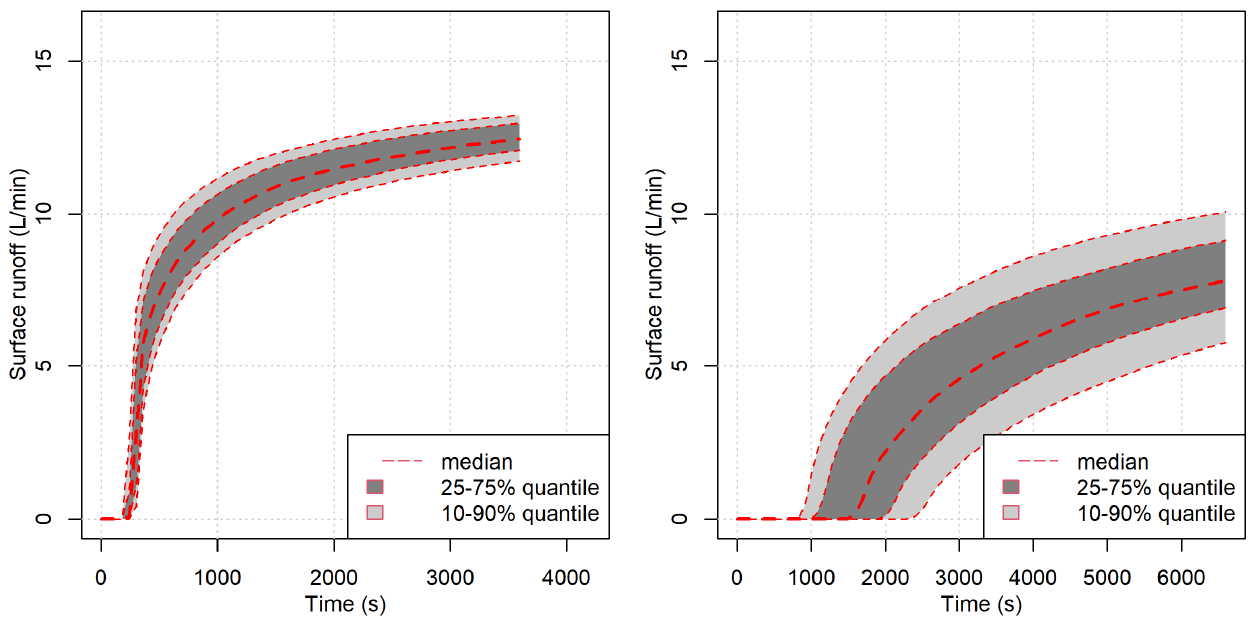
Figure 5. Sensitivity analysis of a bare soil plot ( left ) and a vegetated soil plot ( right ).